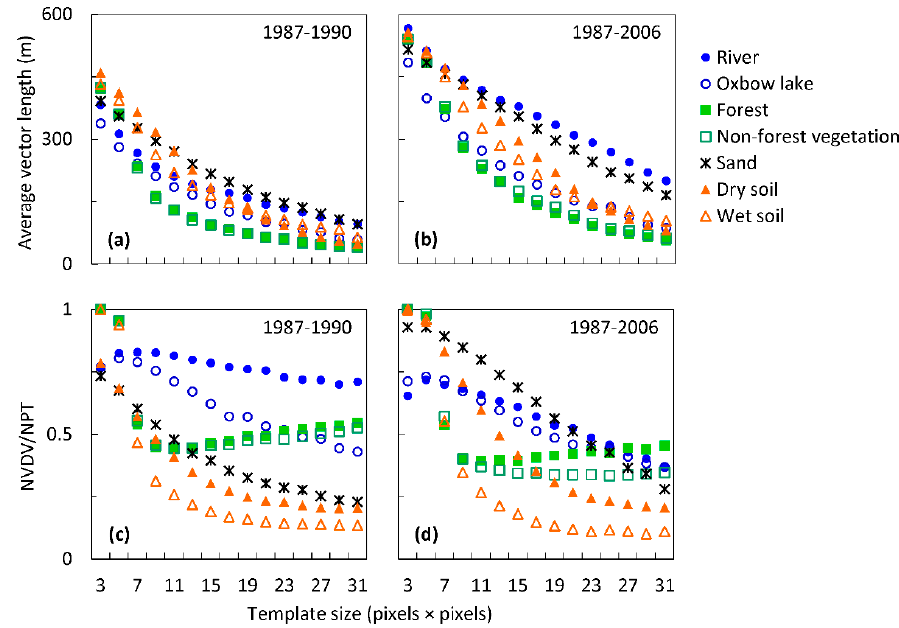
Figure 3. Sensitivity of MCC method to template size. Average valid displacement vector length for the periods of ( a ) 1987–1990 and ( b ) 1987–2006 and the ratio of the number of valid displacement vectors (NVDV) to the number of possible templates (NPT) for the periods of ( c ) 1987–1990 and ( d ) 1987–2006 as a function of template size. Search window size = 50 × 50 pixels, MCC threshold = 0.6.